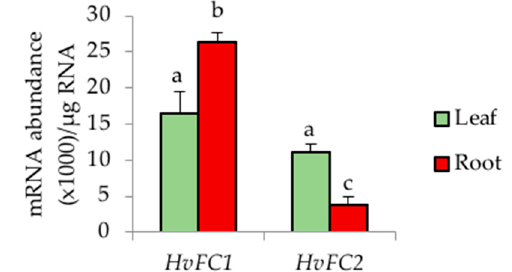
Figure 3. Differential expression profiles of HvFC1 and HvFC2 in photosynthetic and non-photosynthetic tissues. Data are presented as means ± standard error of three replicates. Means with the same letter are not significantly different at p < 0.05, one-way analysis of variance (ANOVA).